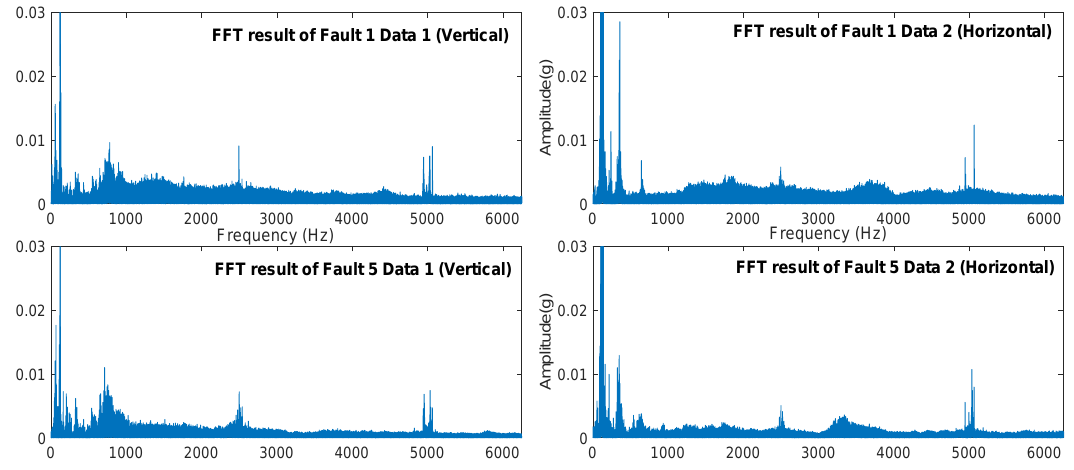
Figure 12. Comparison of the FFT waveform.